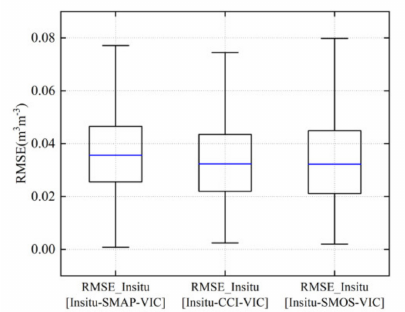
Figure A2. Boxplot of overall in situ station RMSE obtained via three